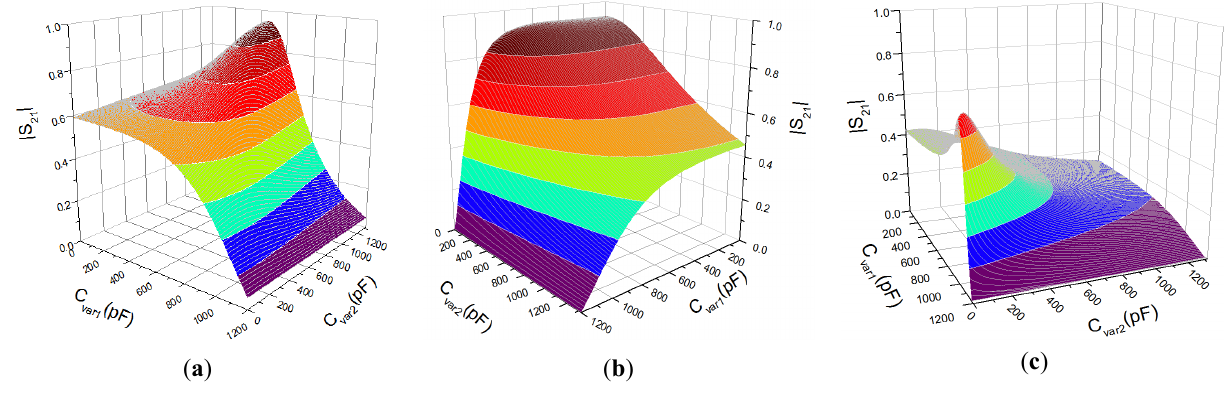
Figure 8. |S 21 | depending on capacitor values: ( a ) d = 15 cm; ( b ) d = 40 cm; and ( c ) d = 80